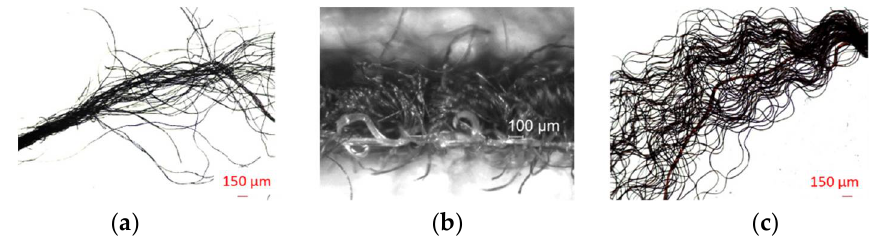
Figure 1. Microscope images of elastane-containing materials ( a ) cotton yarn where elastane was in the core of the yarn; ( b ) knitted cotton textile where elastane is fed backside of the fabric; and ( c ) polyester filament yarn including elastane. Table 2. Recognition of elastane from cotton and polyester blends. Cotton/Elastane